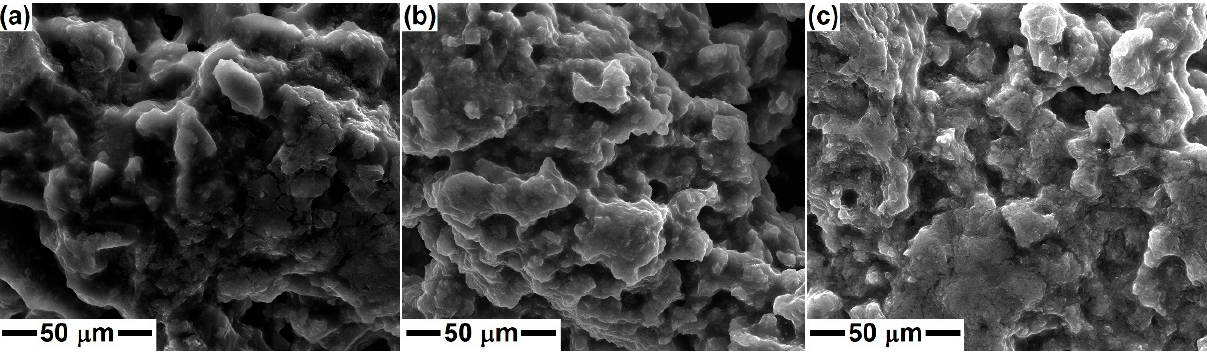
Figure 2. SEM images of the dry gels corresponding to: ( a ) diopside, ( b ) akermanite and ( c ) merwinite compositions.